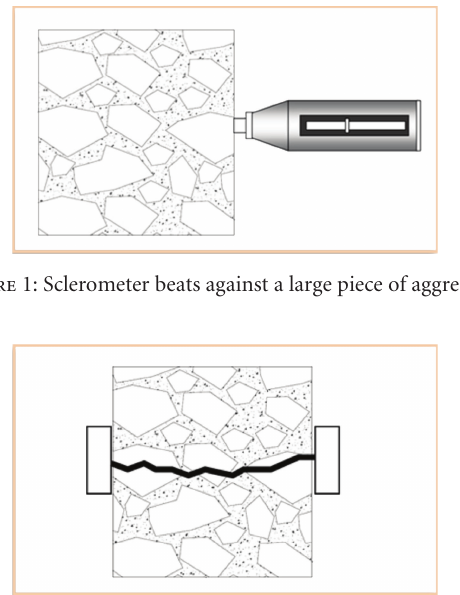
Figure 2: Ultrasound equipment: the impulse